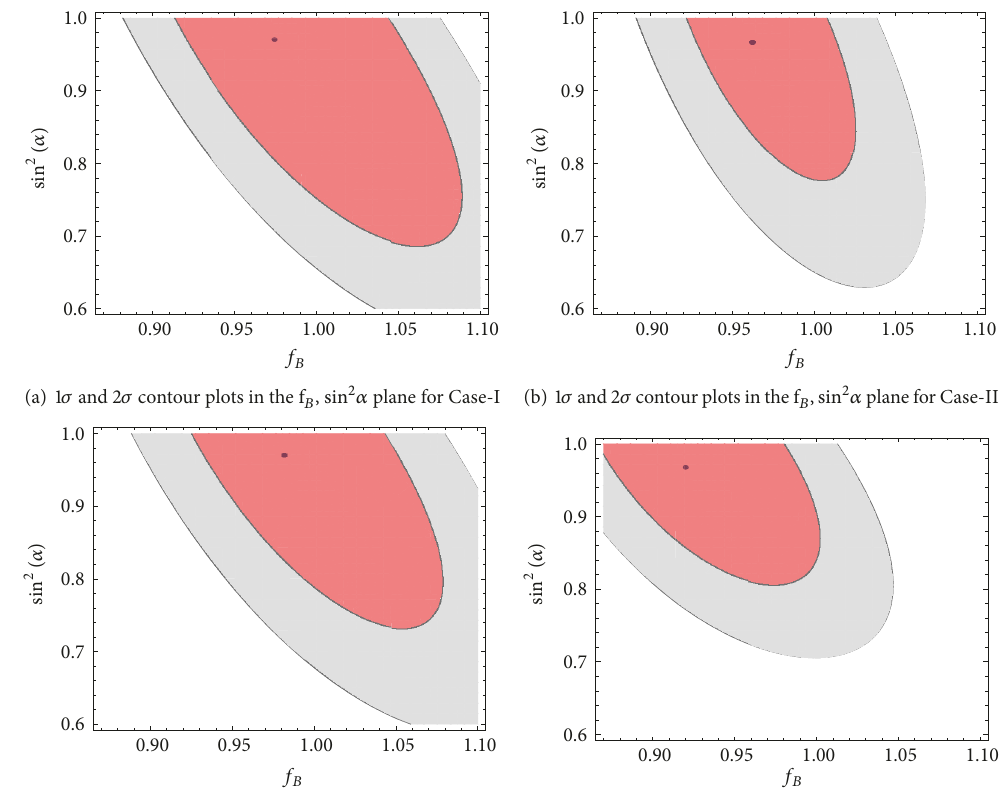
obtained in Set-1 ( 38.7 %) and Set-3 ( 39.3 %), where we